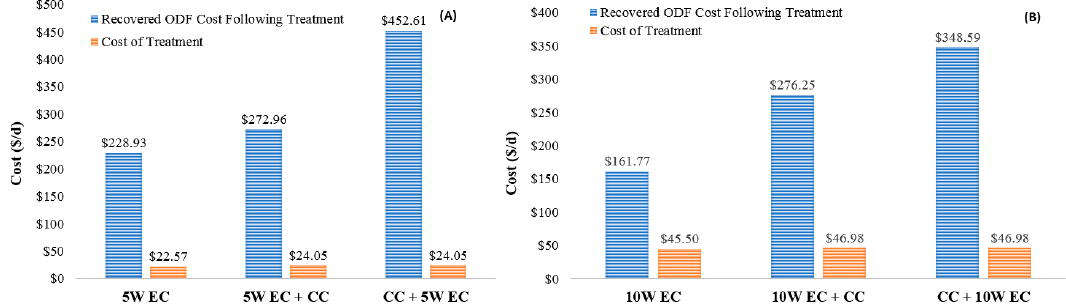
Figure 8. Comparison of recovered ODF cost following treatment and cost of treatment (30-mins treatment time). ( A ) At 5 W applied power. ( B ) At 10 W applied power.